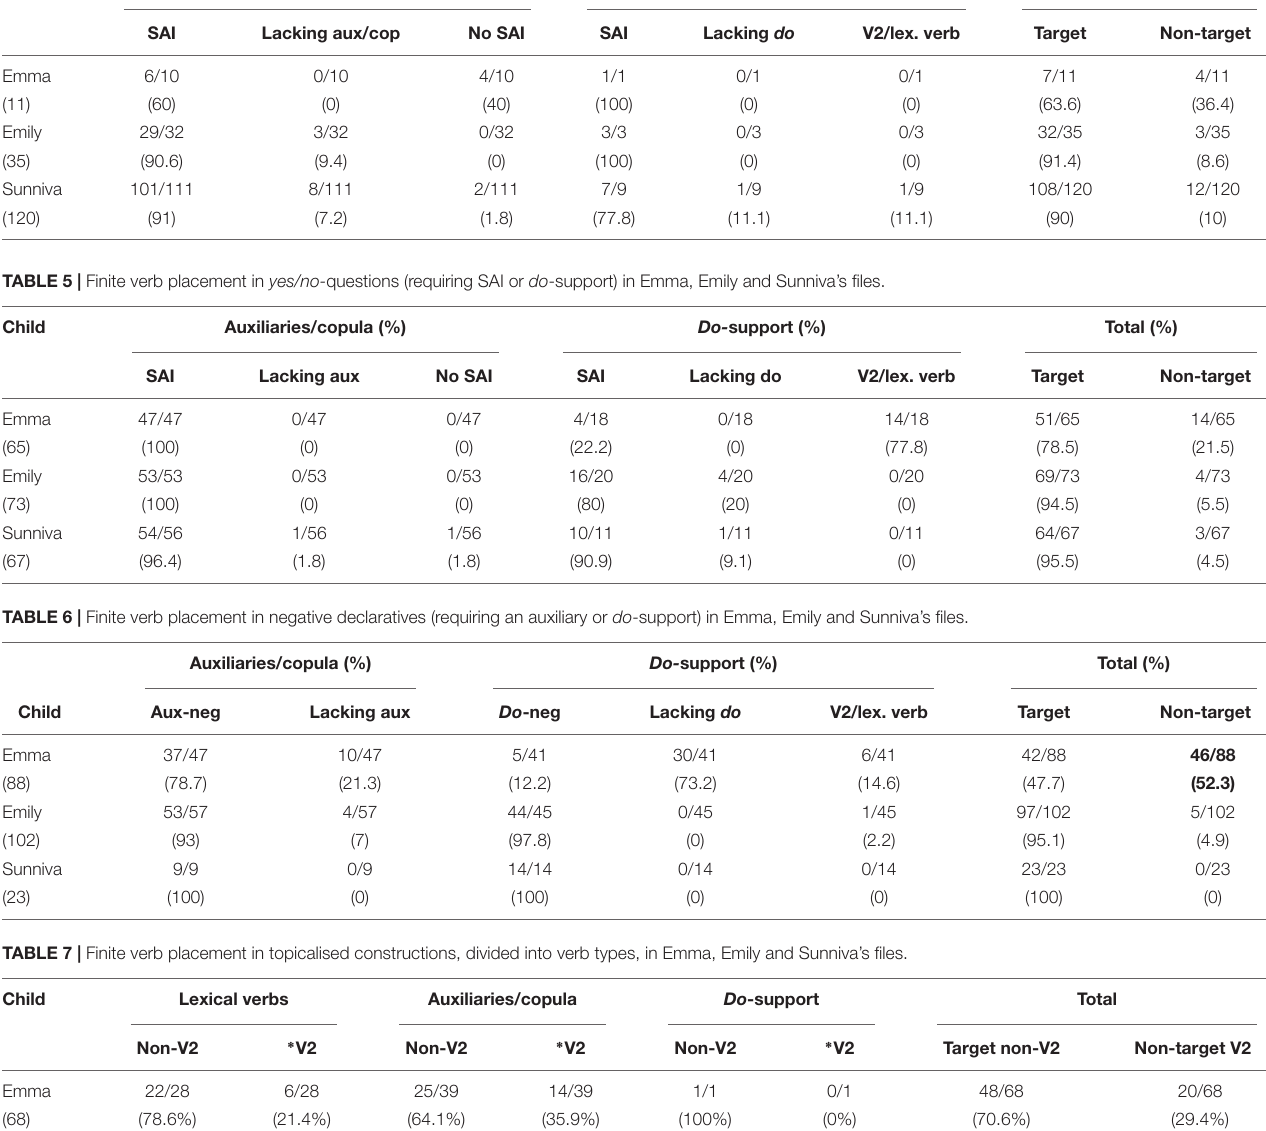
TABLE 4 | Finite verb placement in wh- questions (requiring SAI or do -support) in Emma, Emily and Sunniva’s files. Child